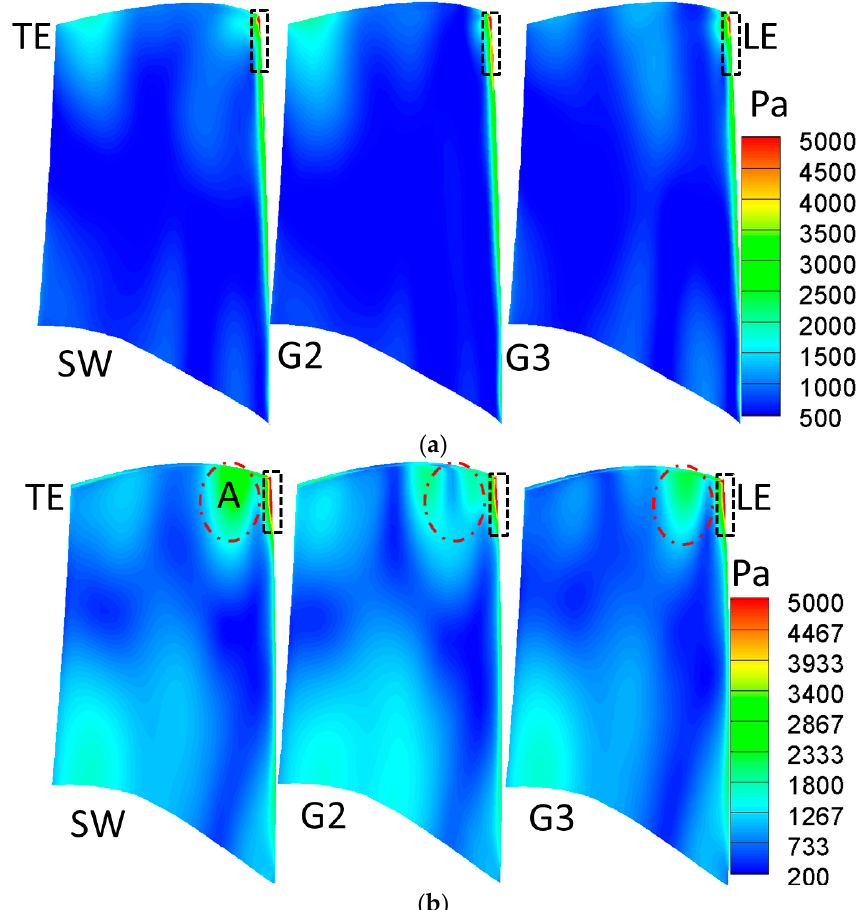
Figure 11. Contours of STD static pressure distribution on the blade surfaces of R2 in different CTs: ( a ) blade suction surface; and ( b ) blade pressure surface.